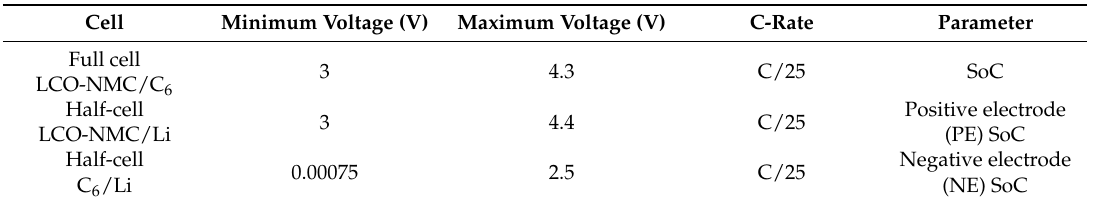
Table 1. Voltage windows and C-rates at which the state-of-charge (SoC) was determined in the full cells and